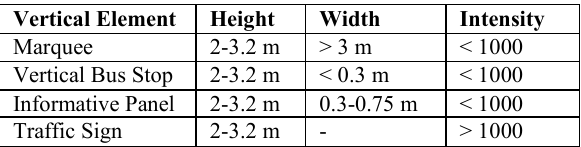
Figure 6. Functional space definition: a) Pedestrian space , b) Bus space , c) Pedestrian & bus